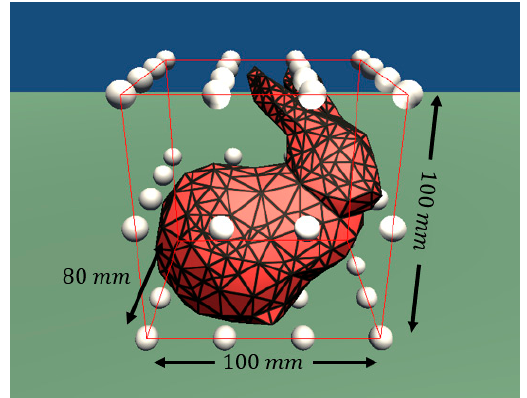
Figure 10. Stanford Bunny model embedded in a lattice of control points (white).